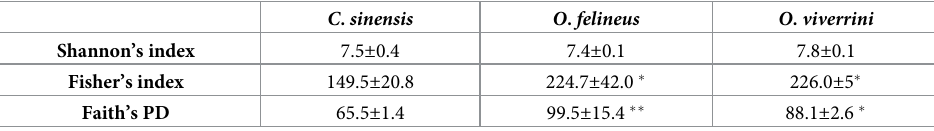
Table 1. Alpha diversity indices of worm